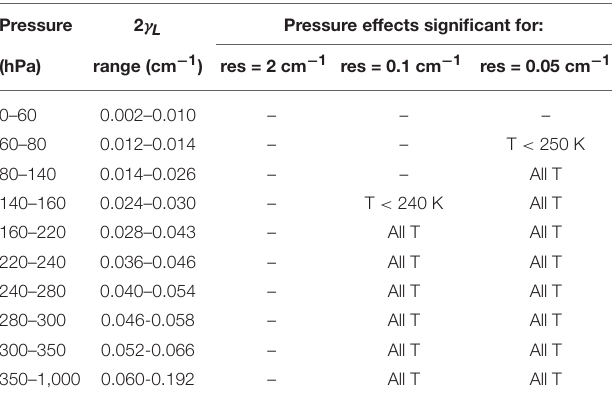
TABLE 5 | Overview of typical values of the pressure broadening parameter γ L and of temperature (T) in the range [220, 294 K] for which pressure effects have to be considered, in the case of NO 2 absorption cross-section at a resolution of 2, 0.1, and 0.05 cm − 1 . Pressure 2 γ L